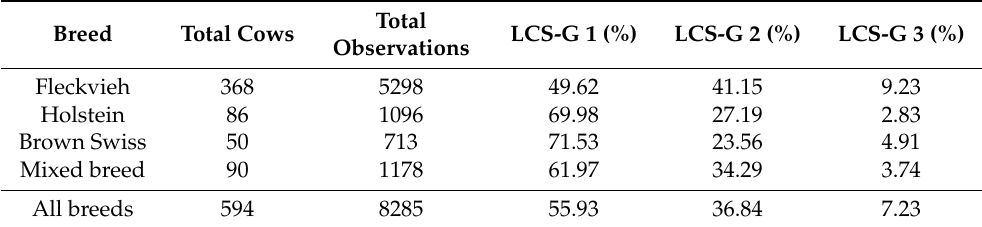
Table 3. Lameness incidence risk on all 10 farms according to breed and for all animals; LCS-G 1–3: locomotion score groups 1 to 3.